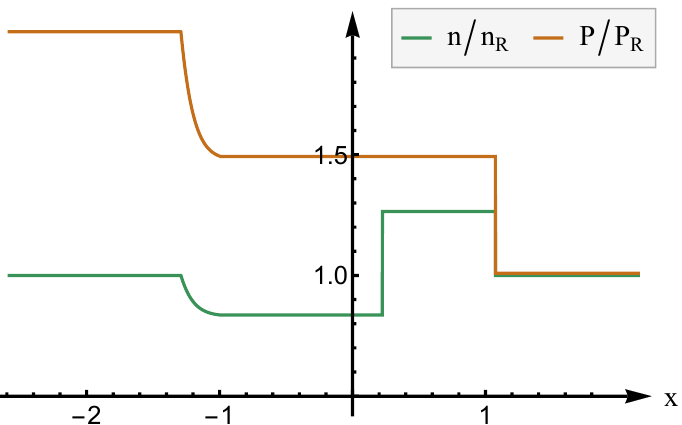
Figure 2. Snapshot of wave pro(cid:12)les for the pressure and charge density at t = t 0 > 0 for P L > P R and n L = n R . The NESS region, bordered by the left-moving rarefaction wave and the right-moving shock wave, contains a contact discontinuity in the charge